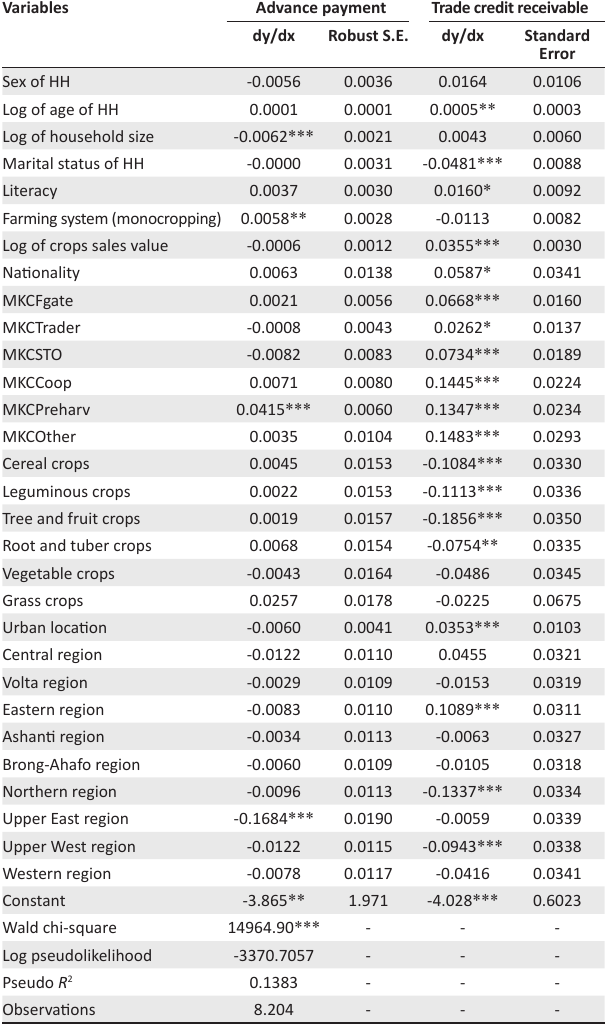
TABLE 7: Determinants of agricultural trade credit use: Multinomial logit results.